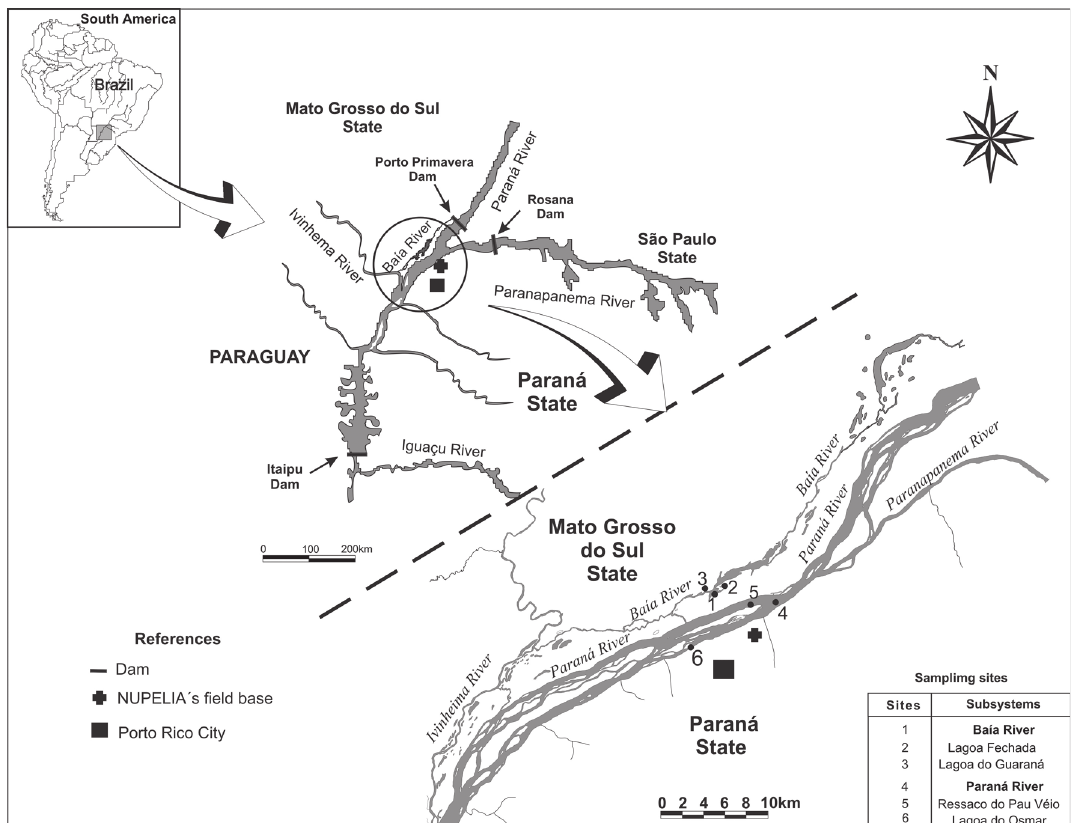
Fig. 1. Upper Paraná River floodplain, with emphasis on sampling points in each